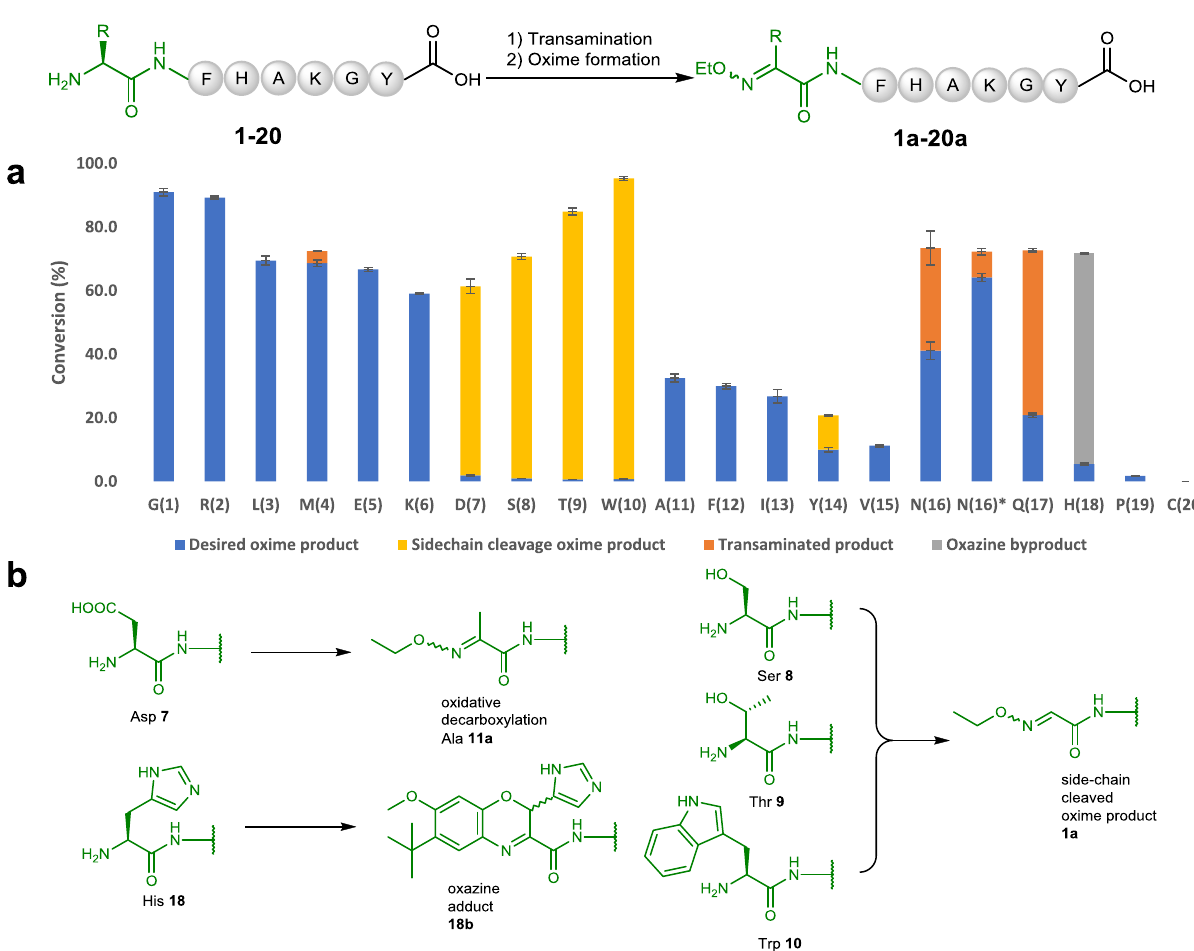
Fig. 3 Transamination of model peptides with different N -termini. a Landscape for the transamination of 20 canonical amino acids attached on the N -terminal residue of the model peptides (Error bars represent standard deviation, n = 3 independent replicates). Reaction conditions: (1) Transamination: Ox1 (10 mM, sat.), 200 mM Na 2 HPO 4 , pH 6.5, 3 h, 25 °C; (2) Oxime formation: EtONH 2 ·HCl (100 mM), pH 4.0, 3 h, 25 °C (oxime formation time for N(16) *: 5 h; b A summary of major unexpected products of transamination at different N -termini with Ox1 . Structures of these products were characterized with 2D